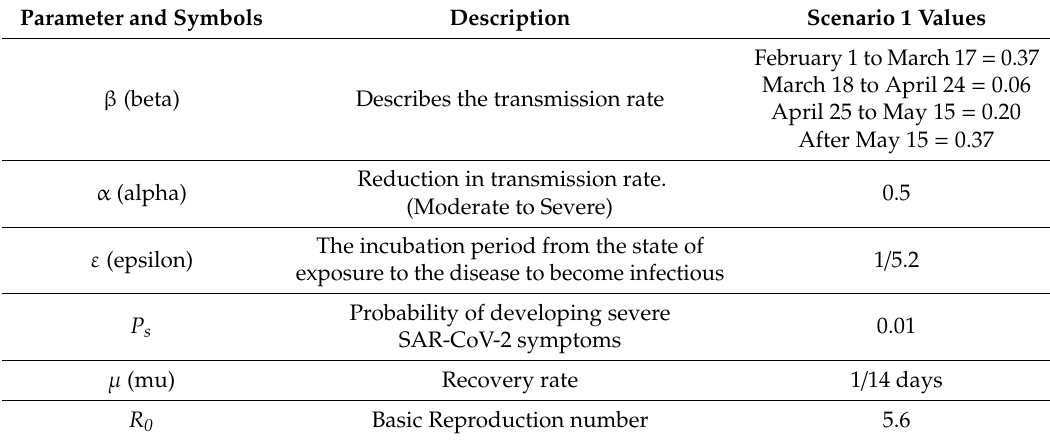
Table 1. Model parameter descriptions and values used for simulating the number of COVID-19 cases in